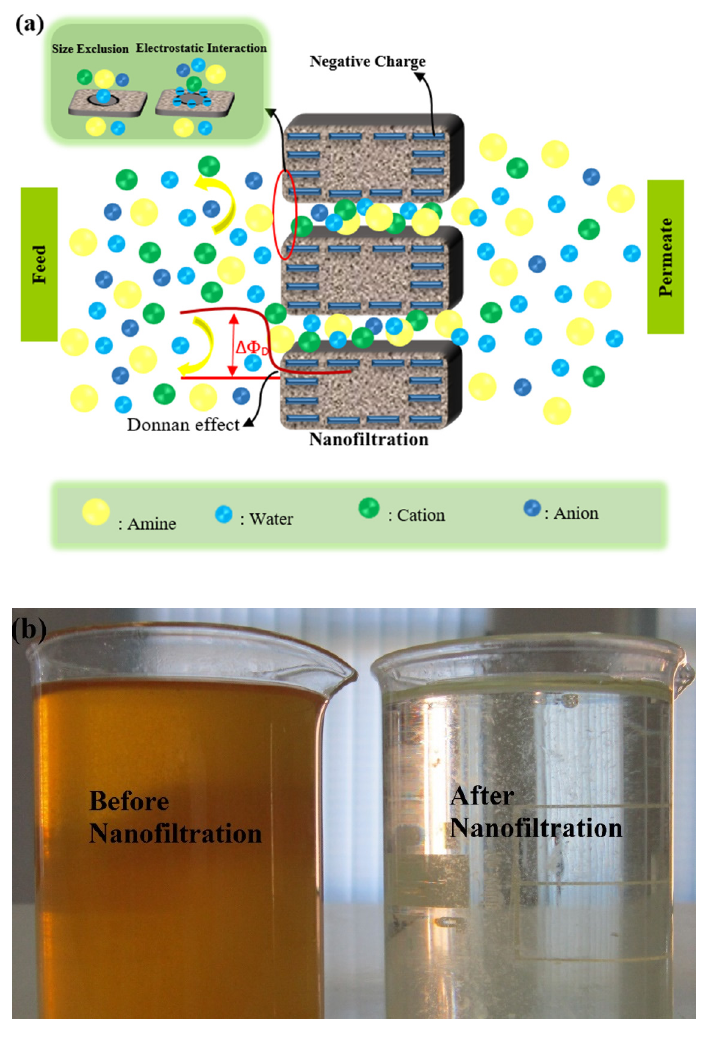
Figure 4. Schematic diagram of the mechanism of ions rejection performance from amine solvent by nanofiltration membrane ( a ), Samples of amine solution before and after nanofiltration process ( b ).